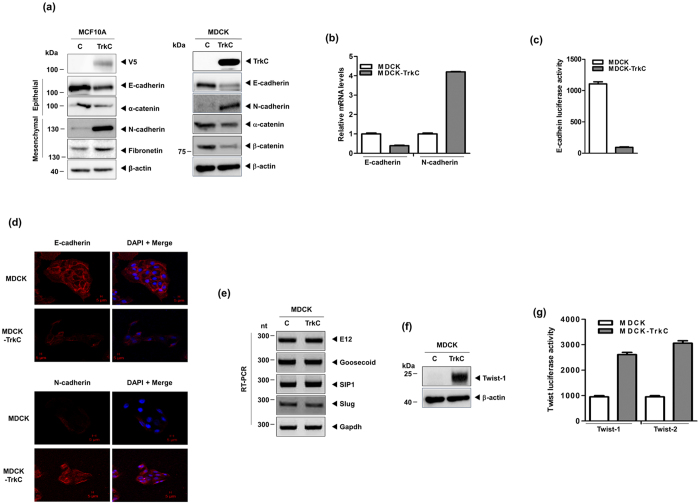
TrkC induces the EMT program by upregulating Twist.(a) Western blot analysis of the expression of TrkC, E-cadherin, α-catenin, β-catenin, N-cadherin, and fibronectin proteins in MCF10A and MDCK control or TrkC cells. β-actin was used as a loading control. (b) The expression levels of mRNA encoding E-cadherin and N-cadherin in MDCK or MDCK-TrkC cells. 18S mRNA was used to normalize variability in template loading. Data are presented as mean ± standard error of the mean (SEM). (c) Luciferase reporter assay of E-cadherin in MDCK or MDCK-TrkC cells. Each bar represents the mean ± SEM of three experiments. Data are presented as mean ± standard error of the mean (SEM). (d) Immunofluorescence staining of E-cadherin and N-cadherin in MDCK or MDCK-TrkC cells. The red signal represents the staining of the corresponding protein, while the blue signal represents DAPI nuclear DNA staining. (e,f) RT-PCR analysis of E12, Goosecoid, SIP1, or Slug mRNA levels (f) and immunoblotting analysis of Twist-1 levels (f) in MDCK or MDCK-TrkC cells. β-actin and GAPDH were used as loading controls. (g) Luciferase reporter assay of Twist-1 and Twist-2 in MDCK or MDCK-TrkC cells. Each bar represents the mean ± SEM of three experiments. Data are presented as mean ± standard error of the mean (SEM). Some of the bar graphs do not have visible error bars due to low values of standard error of the mean (SEM).